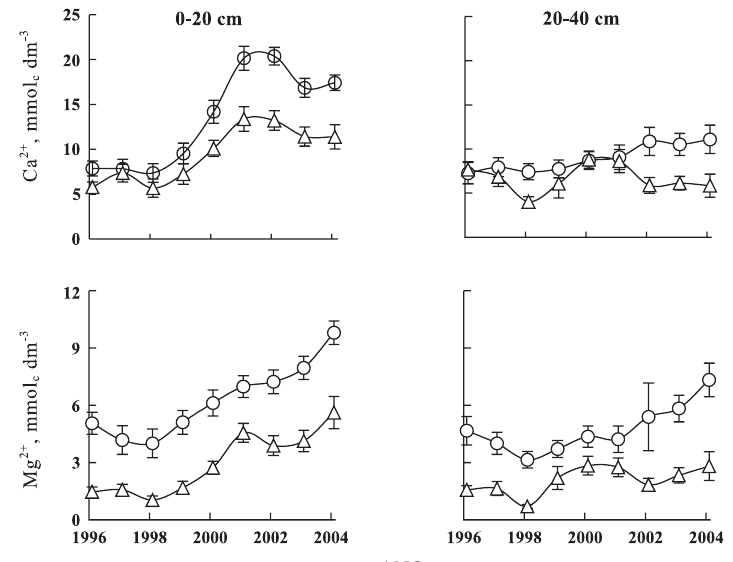
Figura 2. Teores médios e intervalos de confiança da média (p < 0,05) pelo teste t (barras verticais) de Ca 2+ e Mg 2+ , antes (1996) e após as calagens superficiais (1997-1999), nas faixas de adubação ( ) e no centro das entrelinhas ( ) a 0–20 e 20–40 cm de profundidade.